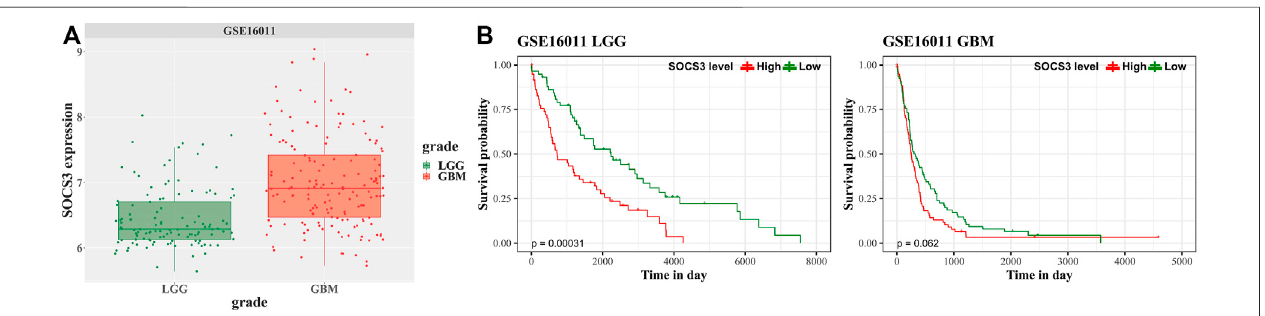
FIGURE4| UnivariatesurvivalanalysisinGBMandLGGstrati fi edbySOCS3expressionbasedontheGSE16011datasetforvalidation. (A) ComparisonofSOCS3 gene expression between the GBM and LGG cohorts from GSE16011. (B) Kaplan-Meier estimates of glioma patient survival according to SOCS3 gene expression.